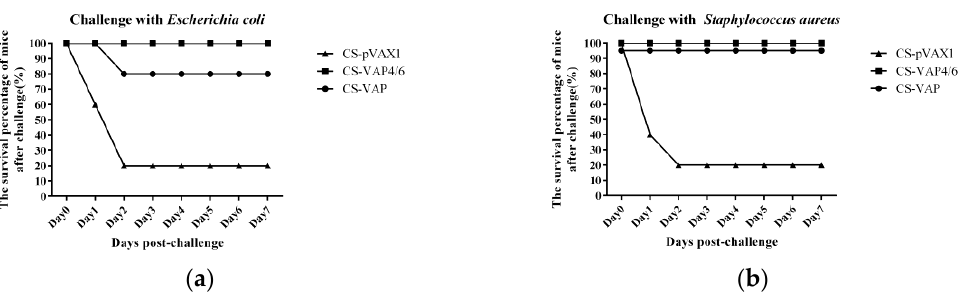
Figure 12. The survival percentage of mice after challenge. It was notable that the mice treated with CS-VAP4/6 respectively showed 100% protection rate against E. coli ( a ) and S. aureus ( b ). Moreover, the group treated with CS-VAP showed a protection rate of 80% and 100% against E. coli and S. aureus , respectively. Meanwhile, the control group only had 20% survival percentage.